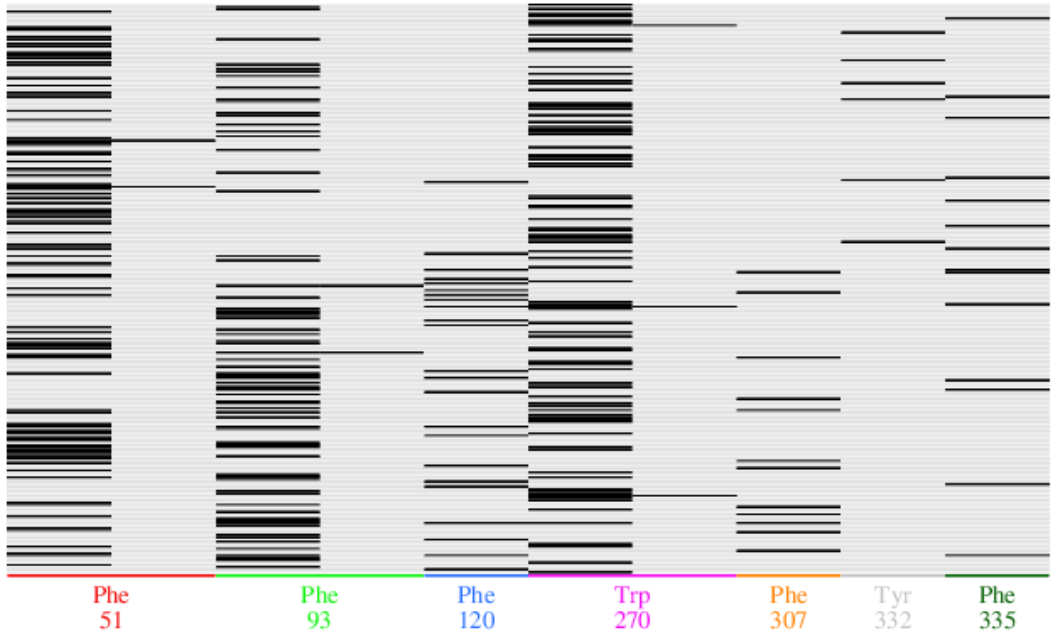
Figure 4. Results of fingerprinting (PLIF) analysis for the interaction of BCO1 with β -carotene. Fingerprints are shown for each residue of the ligand-interacting protein. Each line represents an interaction of the due residue with one atom of the ligand at 100 ns of simulation.